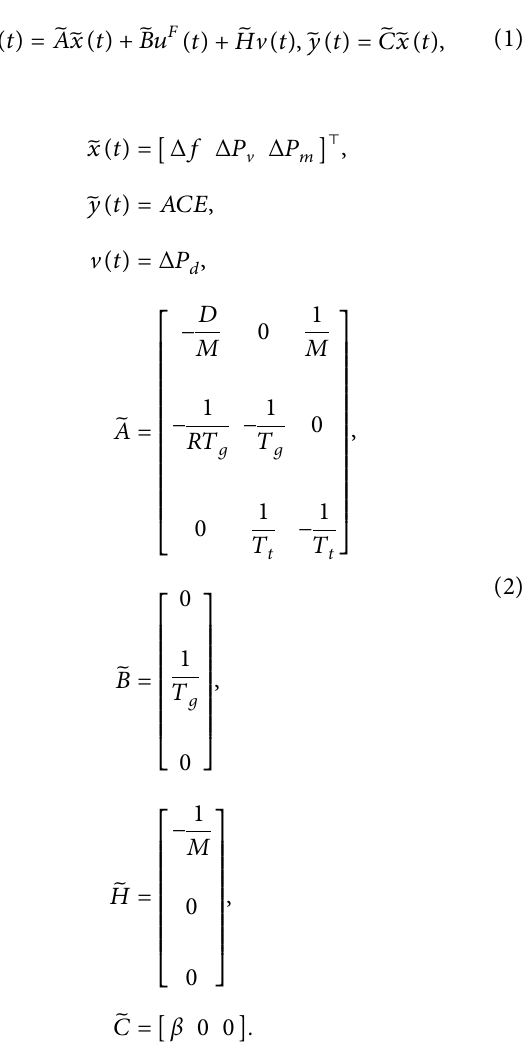
Table 1 provides a list of parameters’ physical